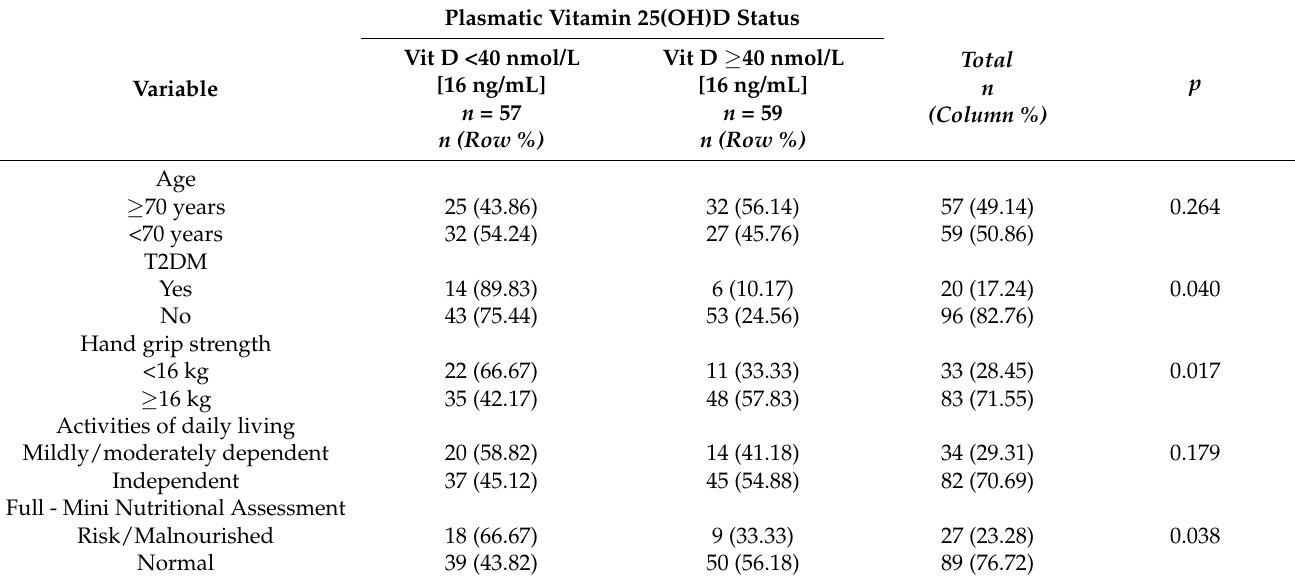
Table 4. Age, handgrip strength, MNA according to plasma 25(OH)D concentration in community dwelling Mexican older women.